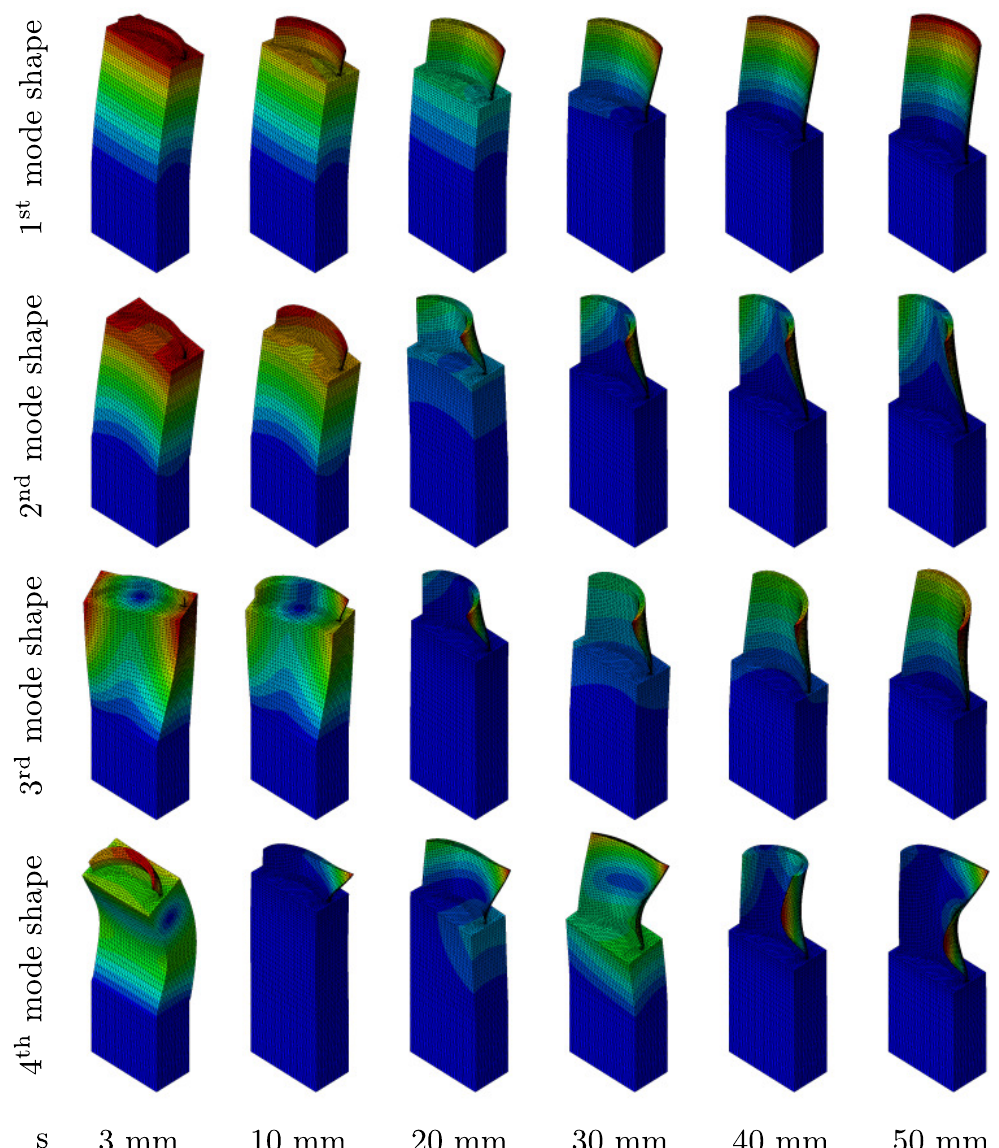
Figure 7. The mode shapes of the first 4 natural frequencies at different blade heights for the ideally fixed flattened